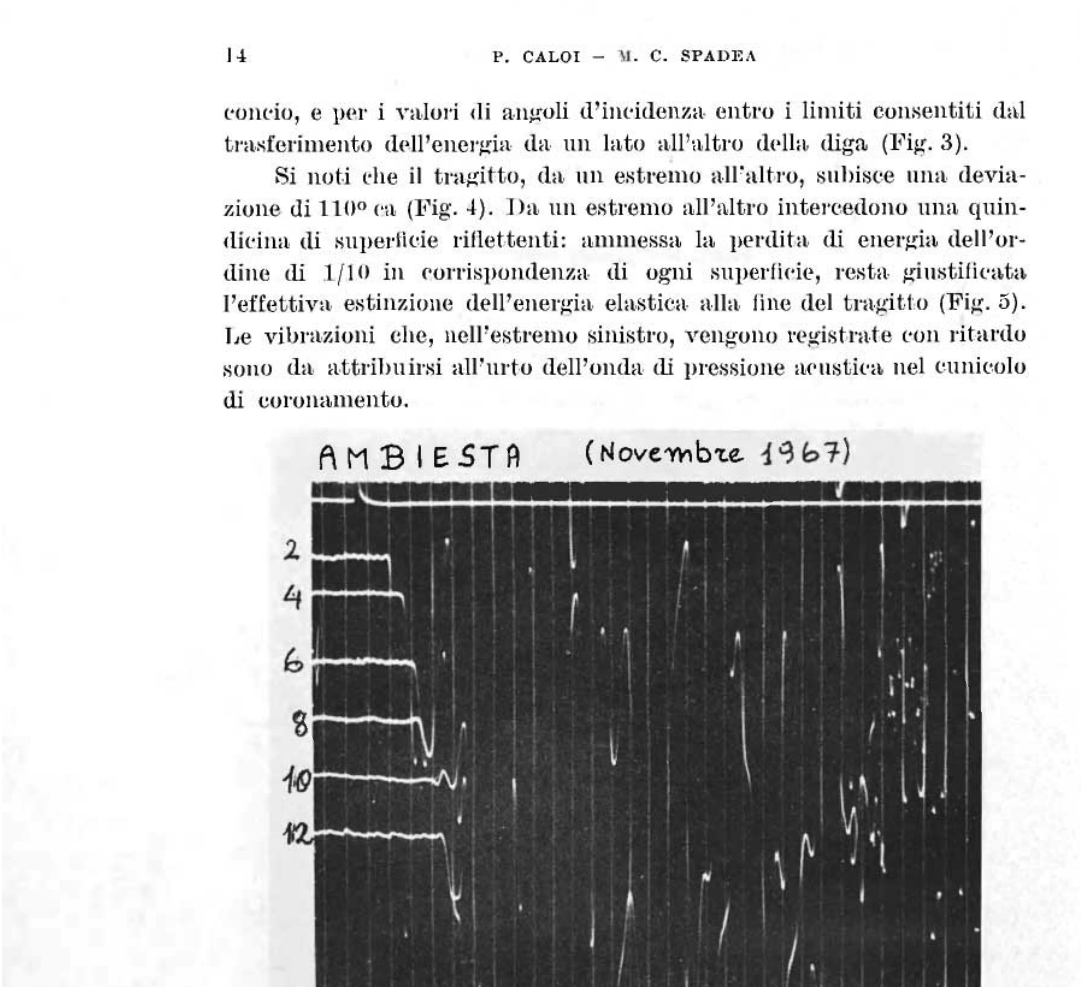
Fig. 6 - Sia pure qualitativamente anche i geofoni (distribuiti come da Fig. 4) danno un chiaro esempio di estinzione dell'energia ela- stica nel suo trasferimento da destra a sinistra. Vedi anche Fig.